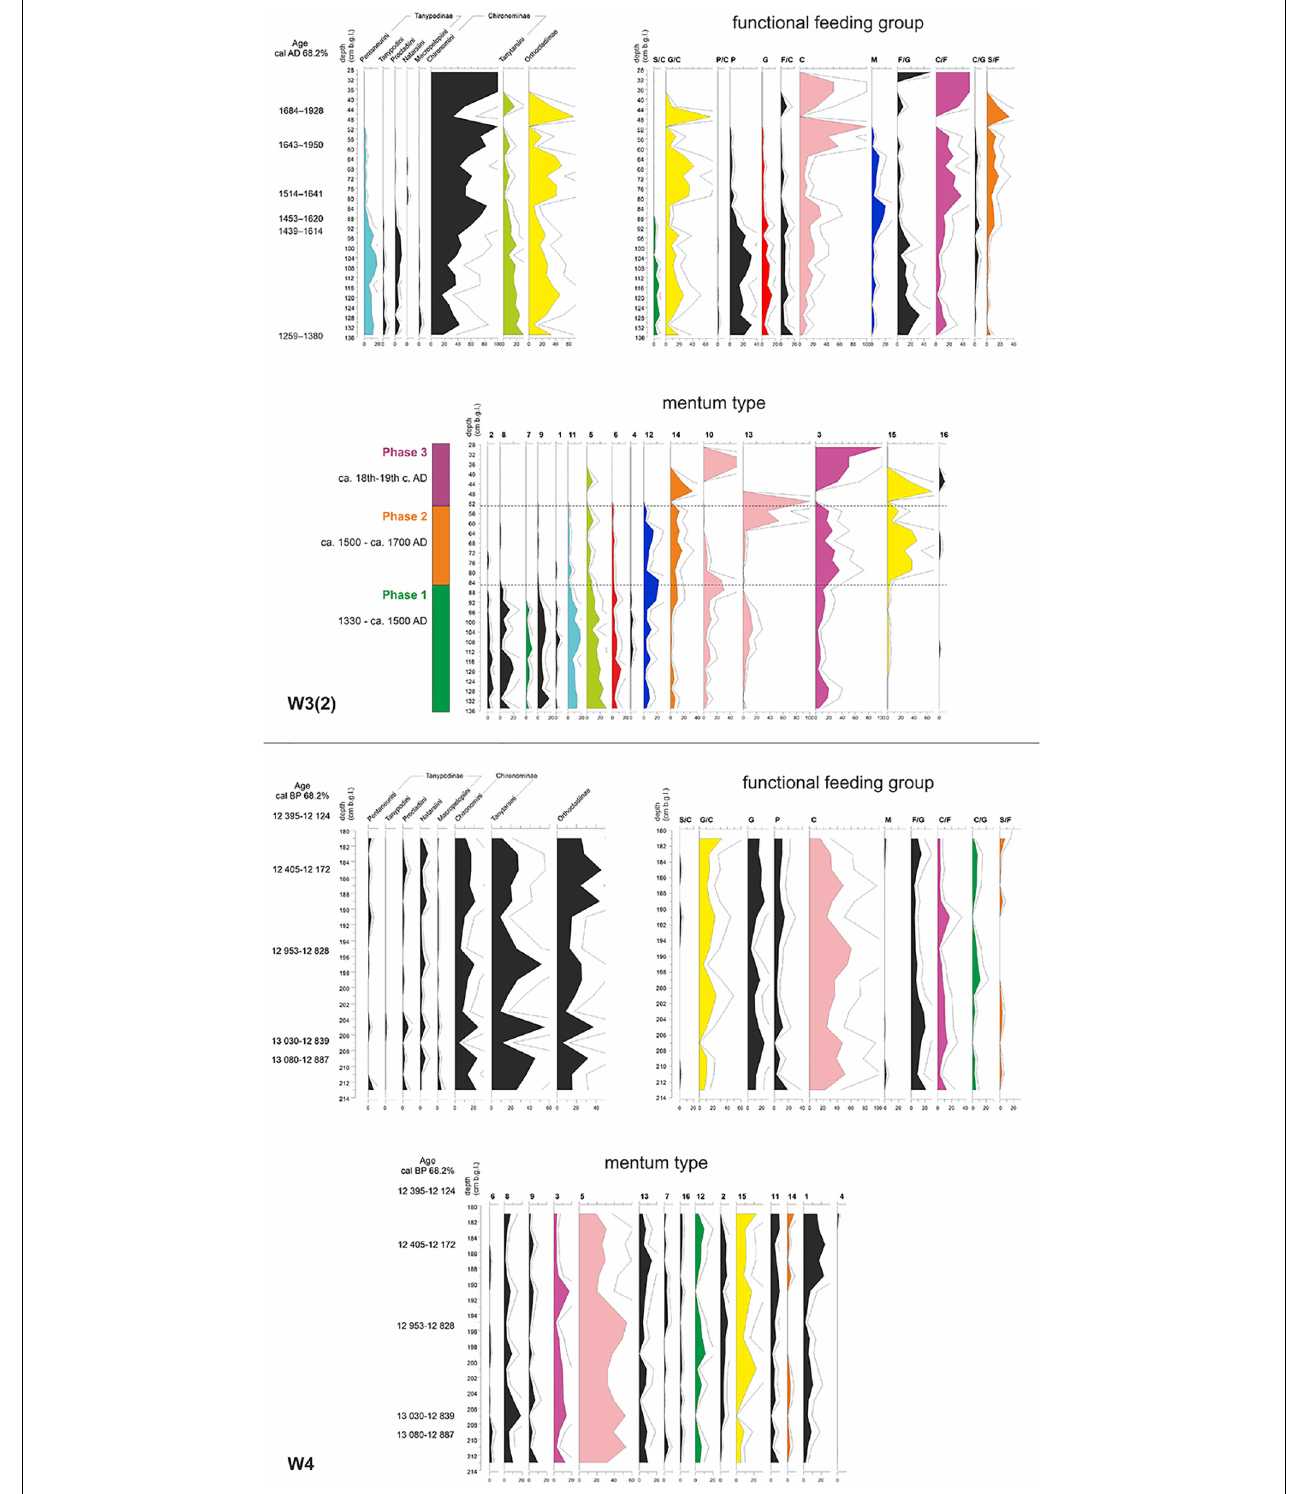
FIGURE 3 | Chironomidae stratigraphic diagrams of the W3(2) (top) and W4 (bottom) cores, according to three typologies: subfamily/tribe, functional feeding groups and mentum types. Similar trends in some groups are outlined by the same graph color. The bar alongside W3(2) diagram represents three phases of the moat development based on Chironomidae assemblages (Kittel et al., 2018a). The abbreviations used for functional feeding groups were as follows: C, collector-gatherers; C/F, collector-filterers; C/G, collectors/grazers; S/F, shredders/filterers; S/C, shredders/collectors; G, grazers/scrapers; G/C, grazers/collectors; F/C, filterers/collectors; F/G, filterers/grazers; M, miners; P, predators; and P/C, predators/collectors. The symbols used for morphological types are explained in Table 1 .